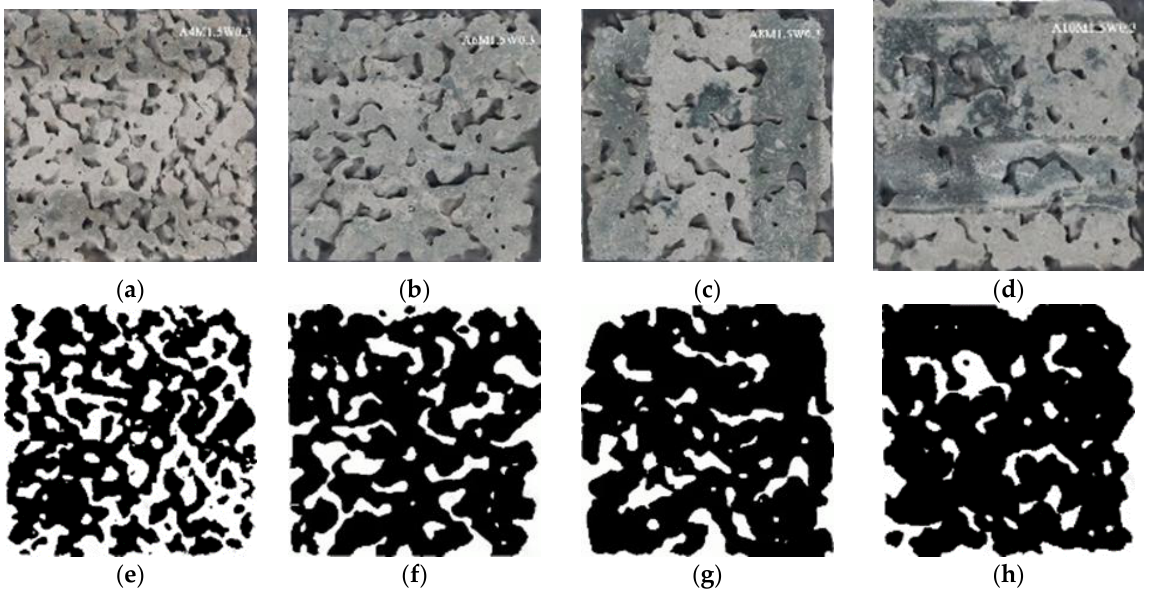
Figure 11. Optical ( a – d ) and respectively binary ( e – h ) images of the bottom of pervious concrete with different water glass content (as Na 2 O content). The side length of images is 100 mm. ( a , e ) 4 wt% Na 2 O; ( b , f ) 6 wt% Na 2 O; ( c , g ) 8 wt% Na 2 O; ( d , h ) 10 wt% Na 2 O.